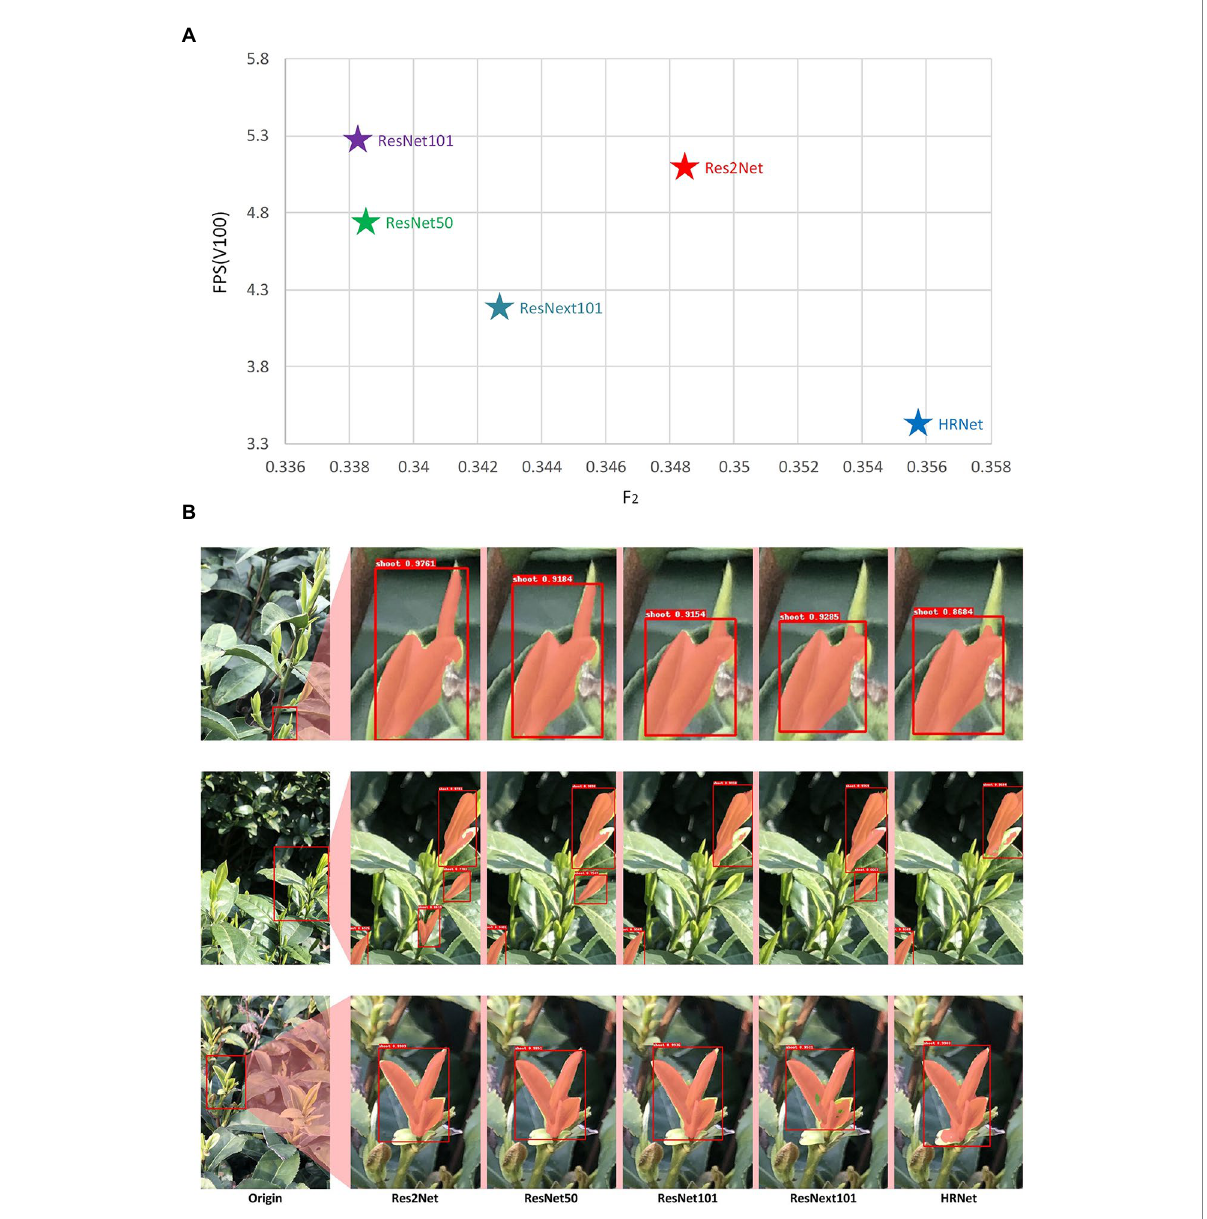
FIGURE 6 Evaluation results of different backbone (A) the relationship between F 2 and FPS of model with different backbones, (B) the practical performance of models with different backbones on selected areas of a larger scene.